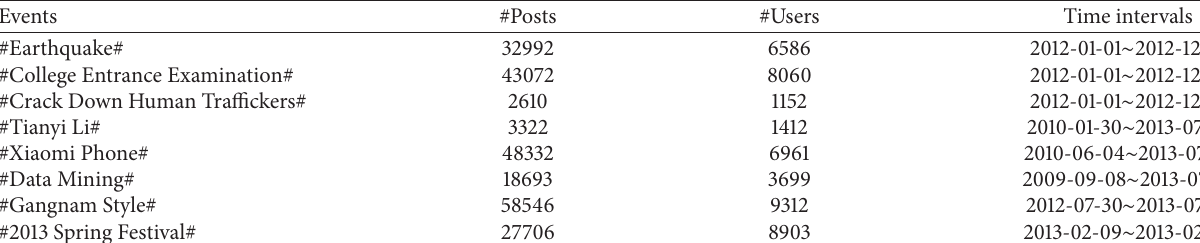
Table 4: Data statistics of each event.